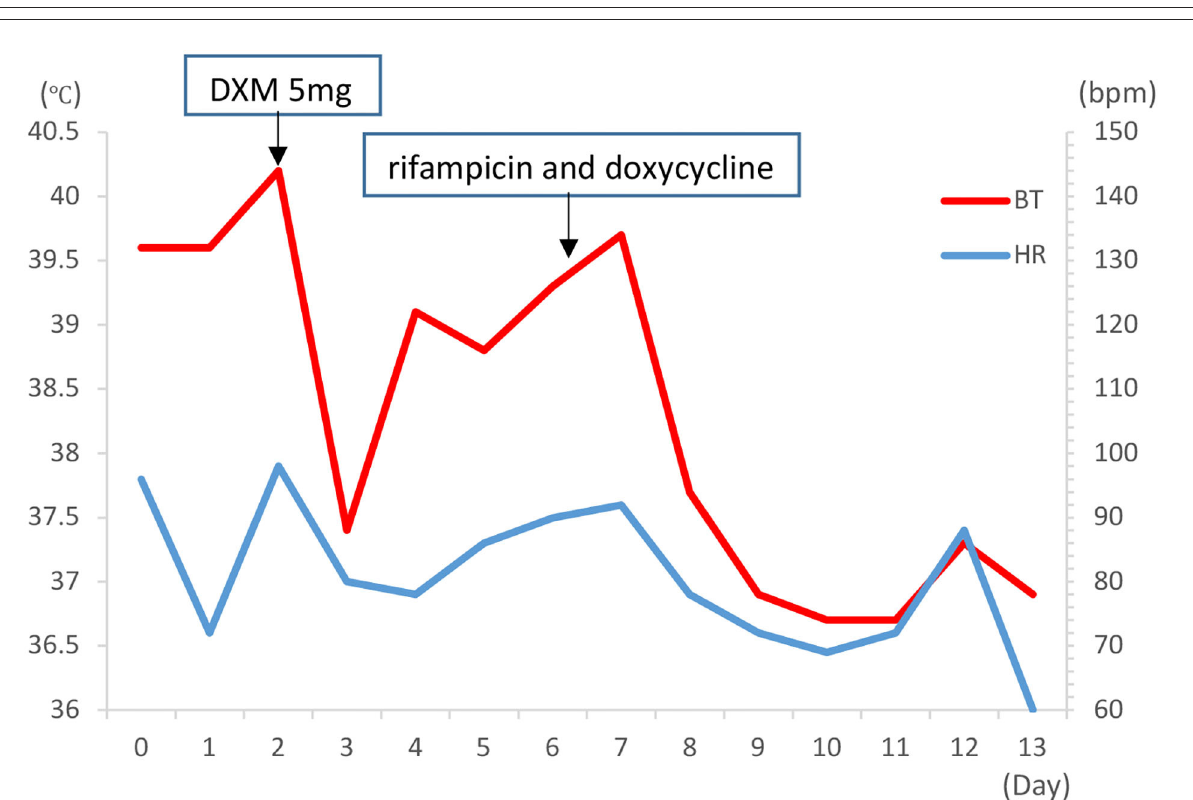
FIGURE2 The time course of heart rate, fever, and treatment in the case (during the first week of hospitalization, persistently high fever with highest temperature > 40 ◦ C, the HR remained within 70–100 bpm with sinus rhythm. bpm, beats per minute; BT, body temperature; HR, heart rate; DMX,